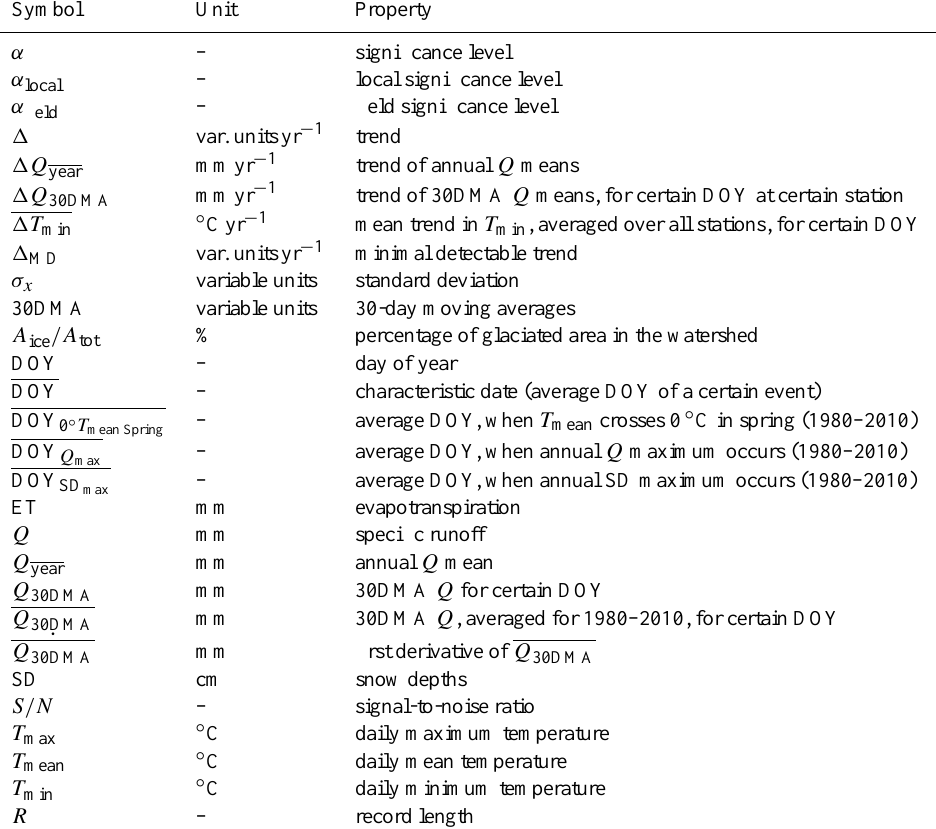
Table A1. List of symbols and